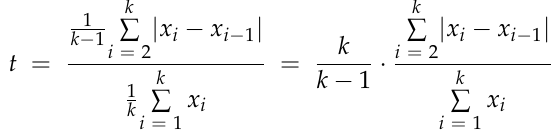
Table 4. Model validation using five-fold cross-validation.